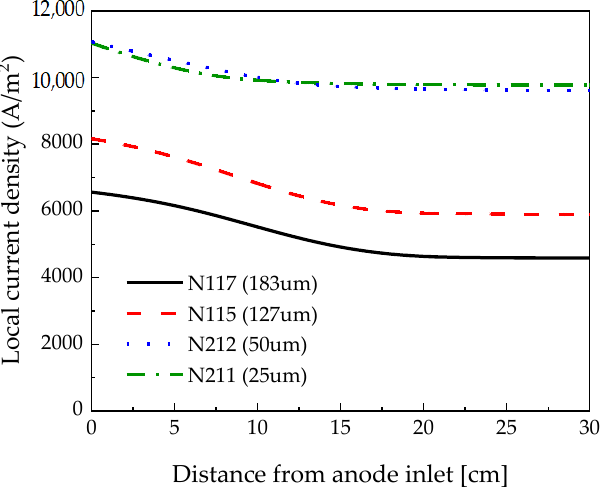
Figure 11. Local current density measured along the channel length according to the polymer electrolyte membrane thickness at 0.18 V.